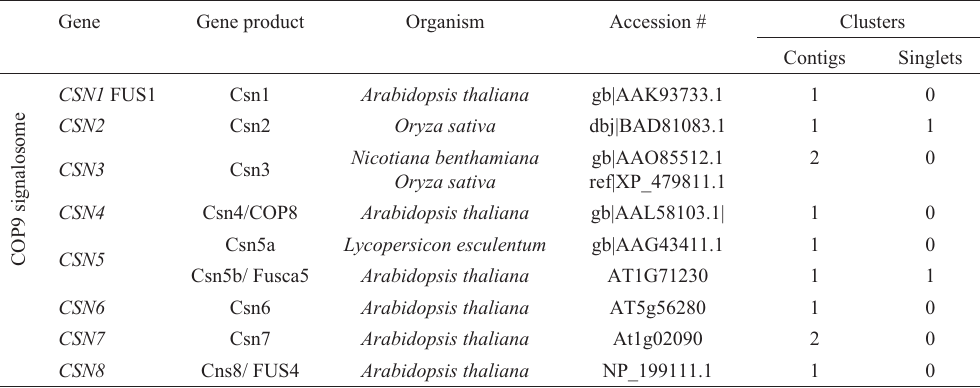
Table 7 - Ortholog genes of COP9 signalosome pathways found in the Citrus EST